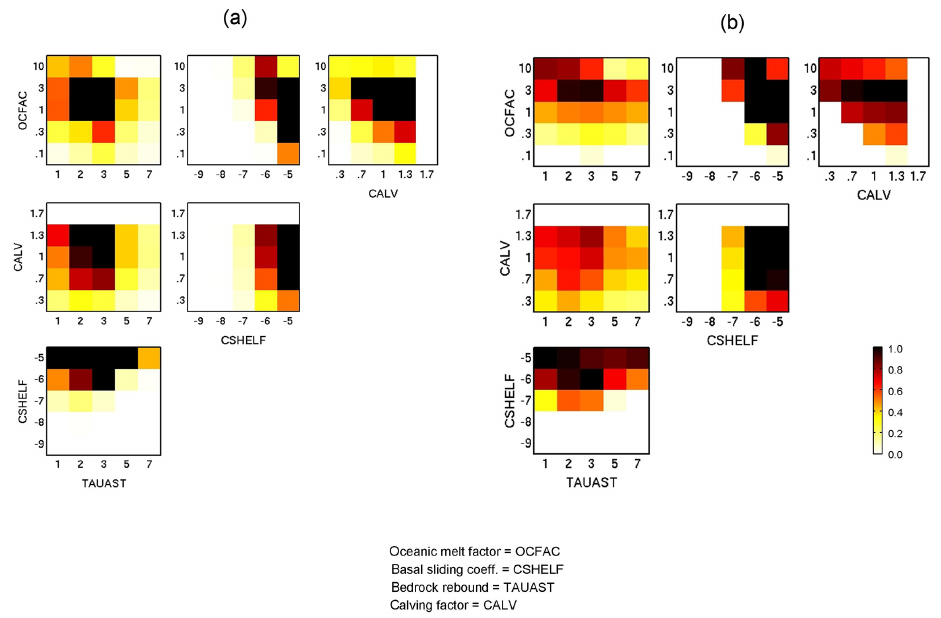
Figure C3. Ensemble-mean scores for pairs of parameters, using the simple averaging method as in Fig. 4. (a) Using the close-to-Gaussian scoring approach (a) (Sect. 2.4, Appendix B). (b) Using the more heuristic approach (b) (Sect. 2.4, Appendix B), exactly as in Fig.